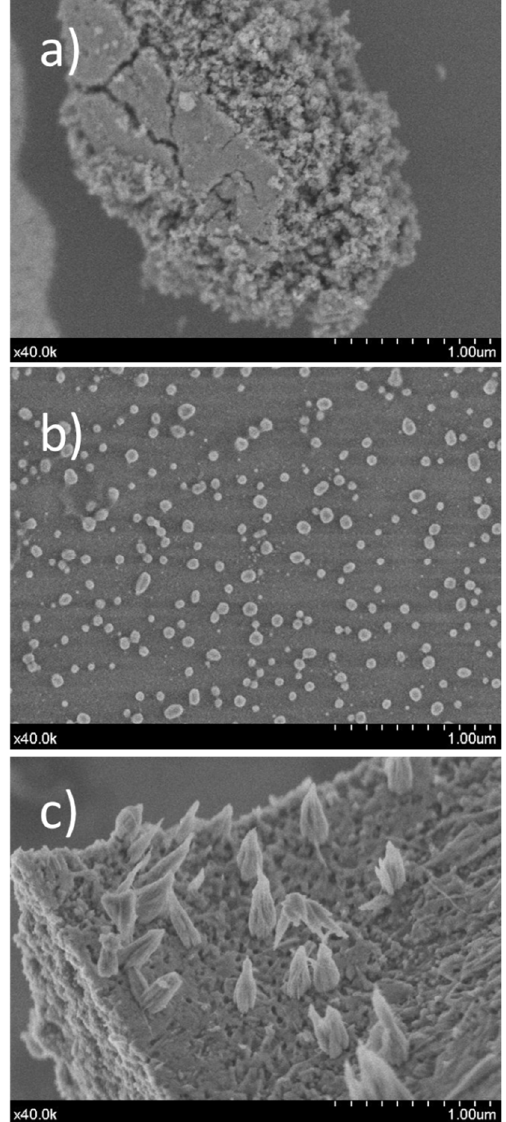
Figure 8. SEM images of post-reaction samples: ( a ) of NiCaAlO-PRx (TOP), ( b ) NiMgAlO-PRx (MIDDLE), and ( c ) NiBaAlO-PRX (BOTTOM).